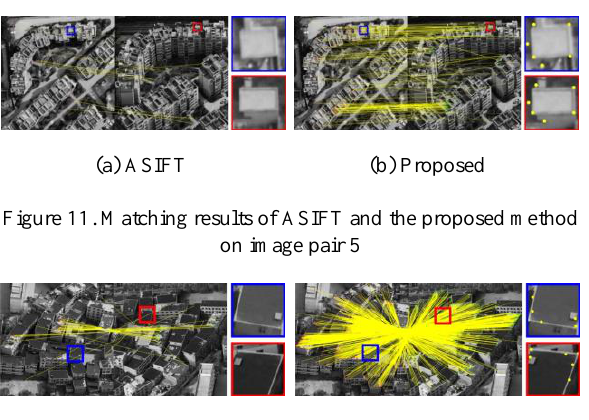
Figure 10. Matching results of ASIFT and the proposed method on image pair 4